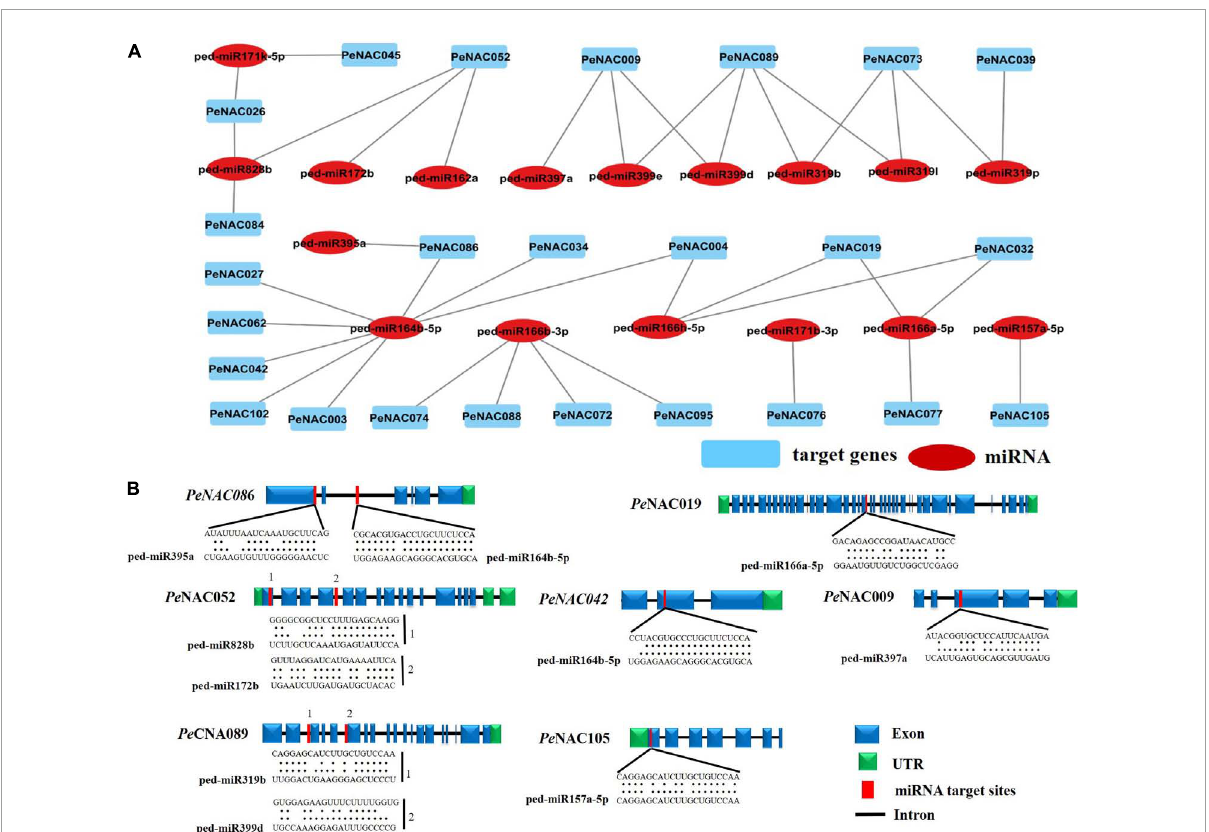
FIGURE7 Predicted miRNAs targeting PeNAC genes. (A) Network illustration of predicted miRNA targeted PeNAC genes. Blue rectangle shapes represent the predicted miRNAs and red oval shapes represent targeted PeNAC genes. (B) The schematic diagram indicates the PeNAC genes targeted by miRNAs and the putative miRNAs sites are indicated by red color, upper sequences are from the gene region and lower sequences are from the